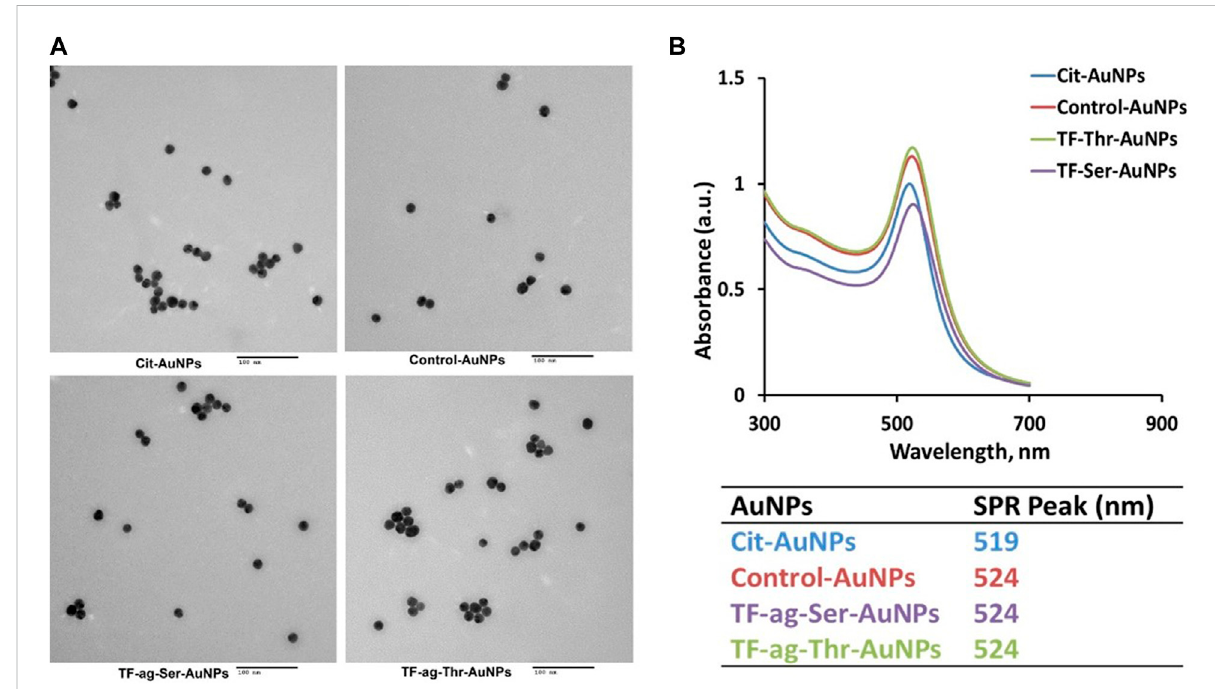
FIGURE 3 (A) Transmissionelectronmicrographsofcitrate-stabilizedAuNPsandofAuNPs 12 – 14 . (B) PlasmonbandUV/VisspectraofsameAuNPsasinA, along with table of SP maximum for each material.